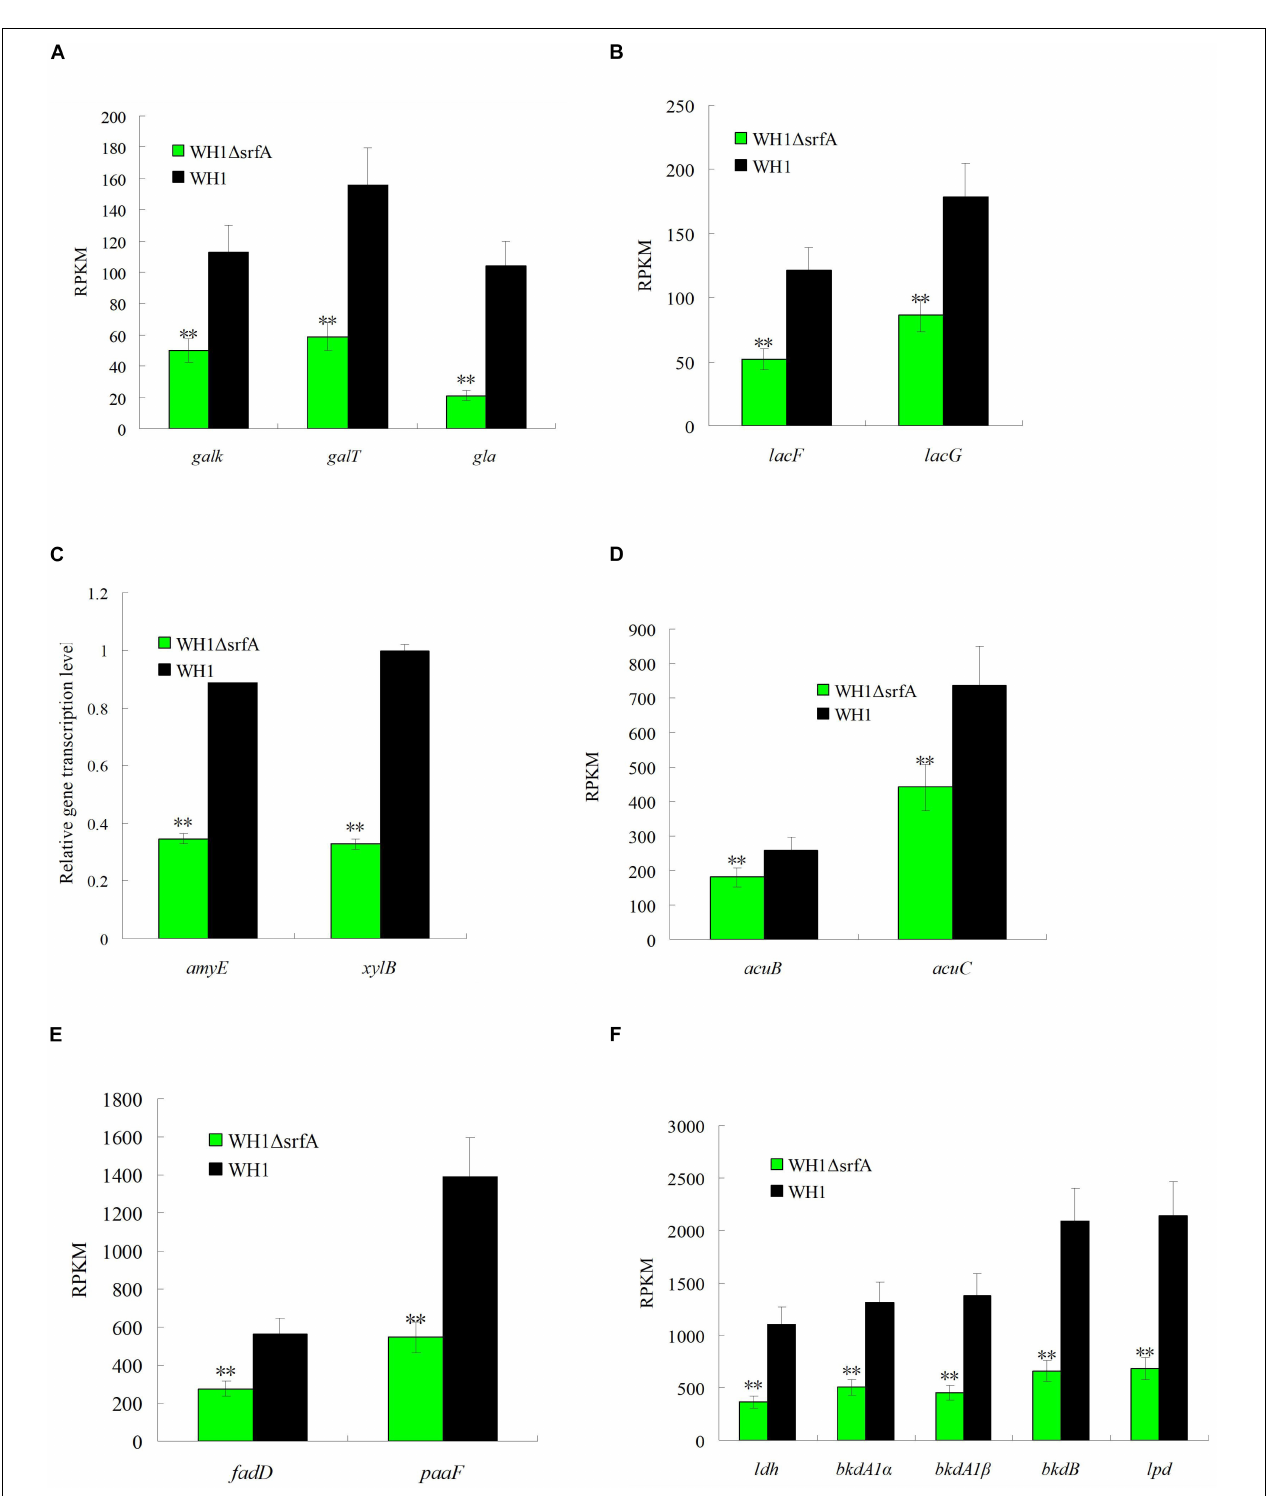
FIGURE 3 | Comparison of the gene transcription involved in utilization of non-preferred carbon sources between (cid:49) srfA and WH1. (A) Galactose. (B) Lactose. (C) Starch and xylose. (D) Acetoin. (E) Fatty acids. (F) Branched-chain amino acids. (A) , (B) , (D) , (E) , and (F) were analyzed on the basis of transcriptomes, and (C) was analyzed by qRT-PCR. Double stars indicate significant difference ( p < 0.01) between (cid:49) srfA and WH1.